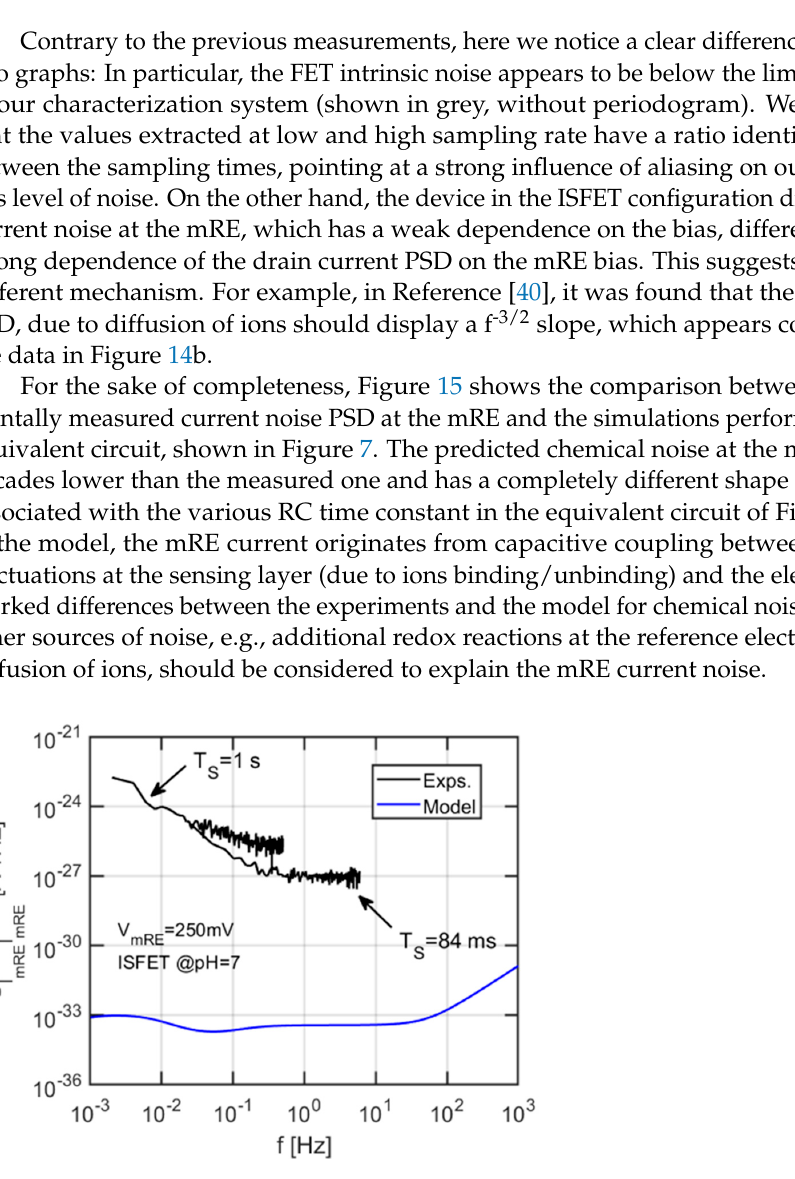
Figure 15. Comparison between the mRE current noise PSD from experiments (black lines, for two different sampling times) and the model with chemical noise at the sensing layer. It appears clear that the influence of the latter is negligible at the fluid gate.